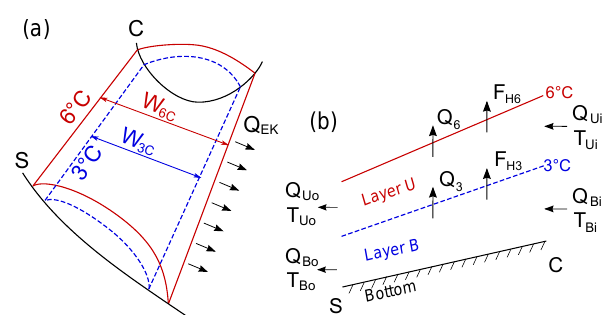
Figure 15. A schematic view of the overflow plume between sec- tions C and S, demonstrating the components of the heat budget. The 3 ◦ C isotherm marks the upper limit of the bottom (B) layer, and the 6 ◦ C isotherm the upper limit of the upper (U) layer.